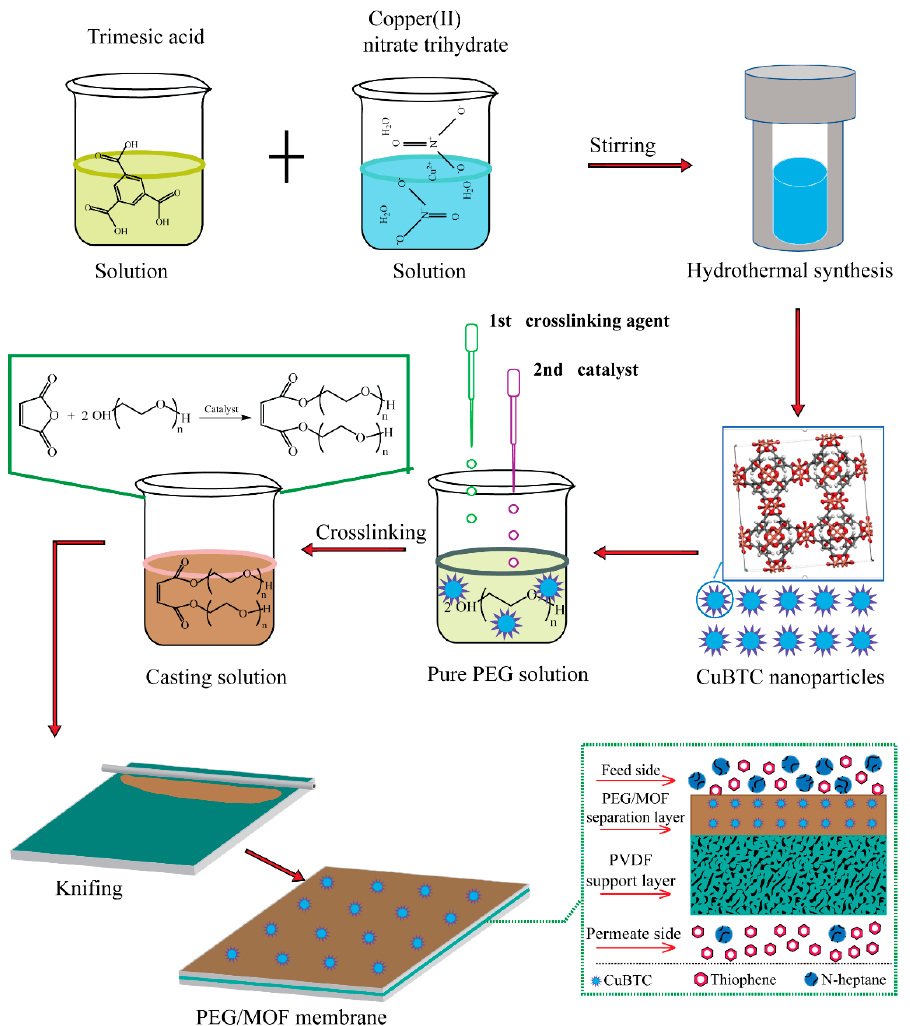
Figure 1. The schematic of preparation of the copper benzene-1,3,5-tricarboxylate (CuBTC)-filled polyethylenglyol (PEG) mixed matrix membranes (MMMs).